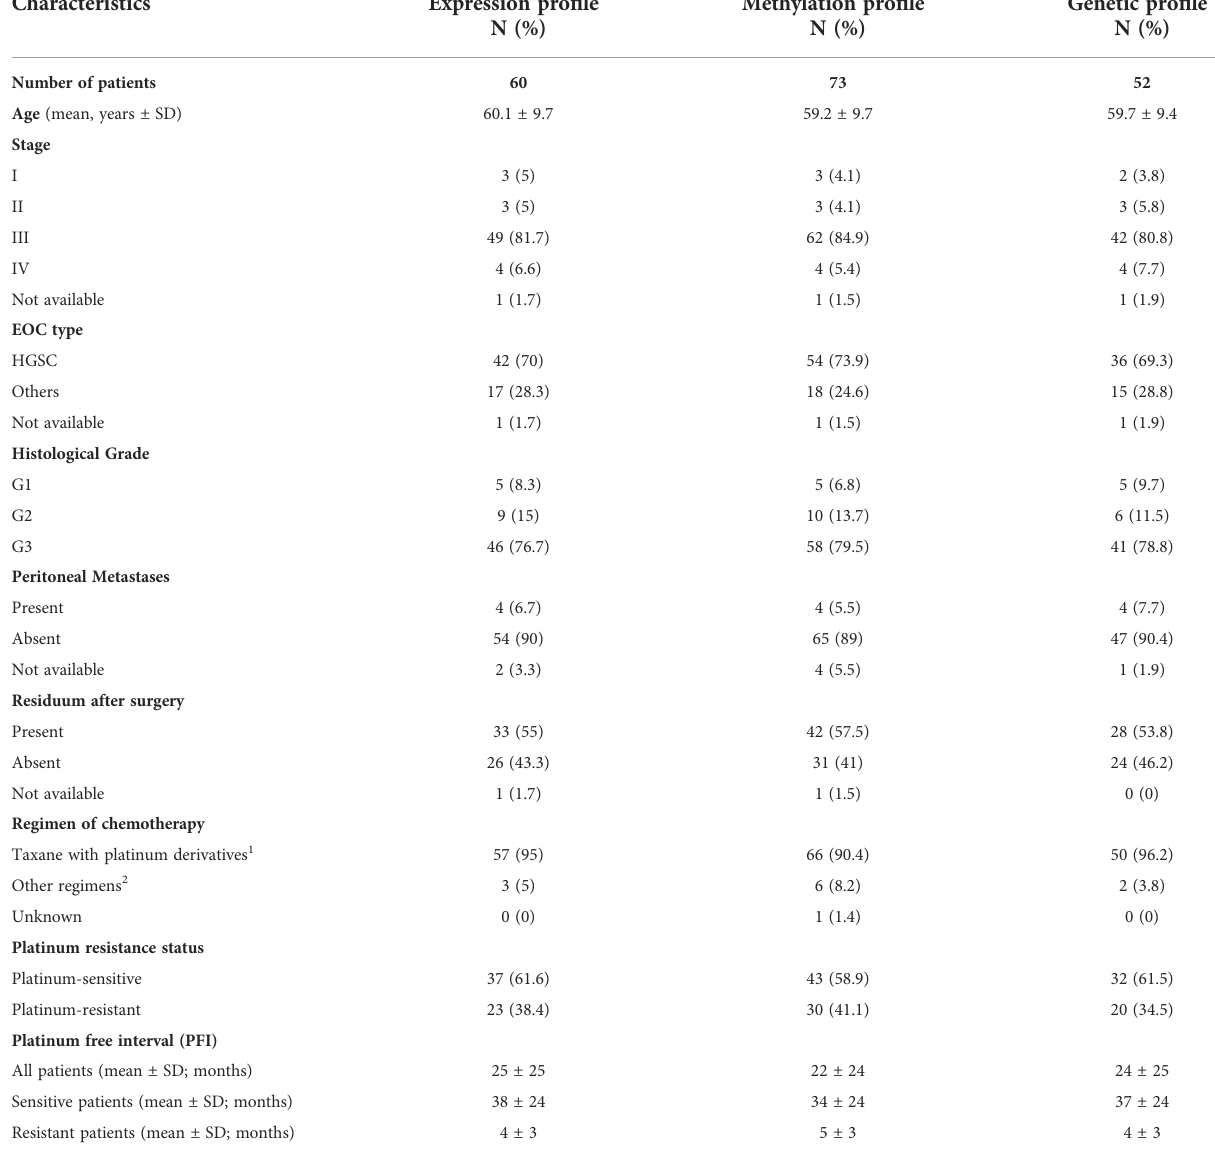
TABLE 1 Detailed clinical characteristics of EOC patients enrolled in the gene expression pro fi le, methylation pro fi le and WES pro fi le analyses.